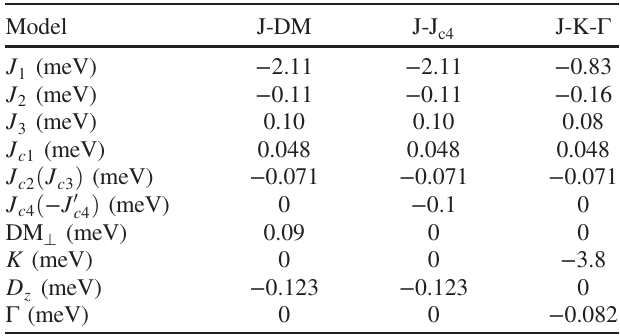
TABLE I. Magnetic exchange interaction strength (the negative value indicates the FM exchange) in the J-DM model, the electron correlation model, and the J-K- Γ model. Our estimated DM ⊥ ≈ 0 . 09 meV is similar to that in Ref.